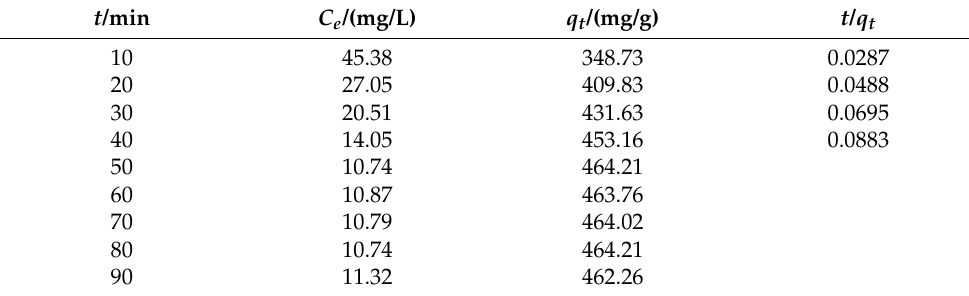
Table 4. Adsorption kinetic data of crystal violet on MCM-41.